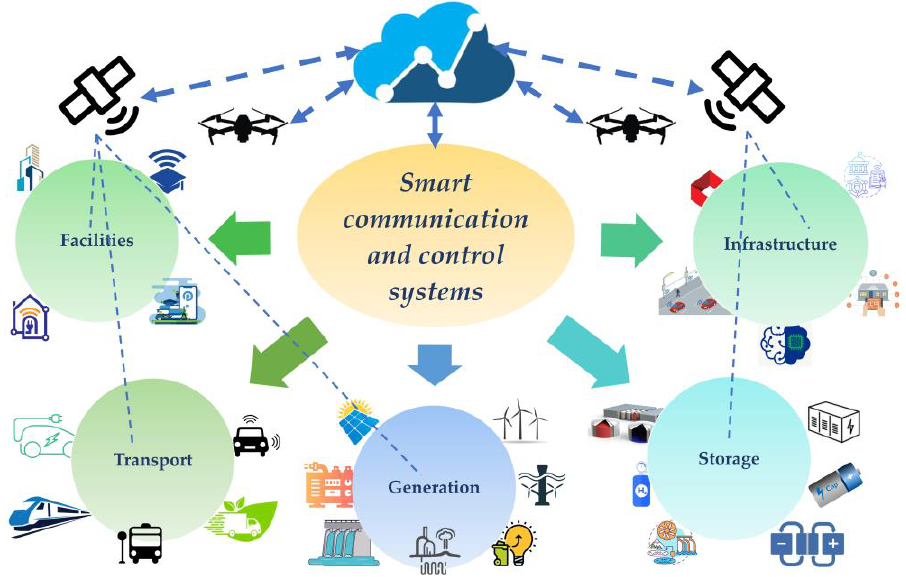
Figure 2. Smart city energy model components [25,51,52].